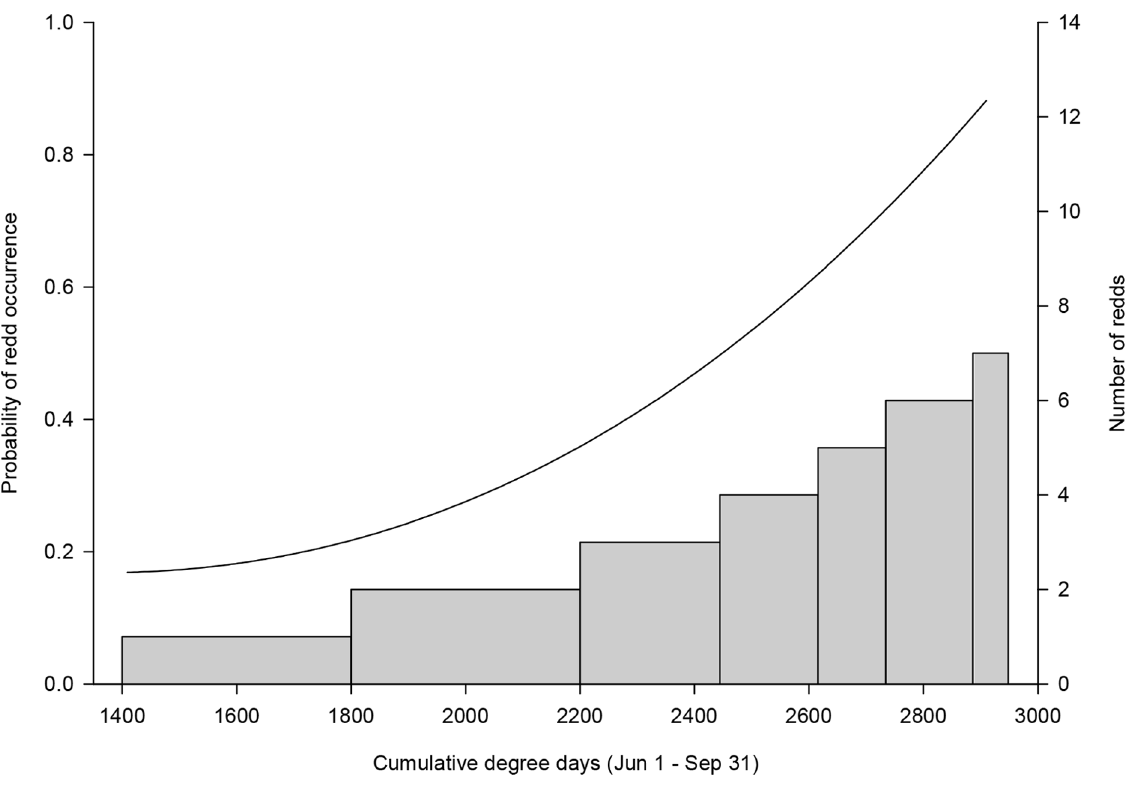
Figure 3. Probability of occurrence (line, left y-axis) and abundance of steelhead redds (bars, right y-axis) as a function of cumulative degree days (GSDD; 6 C) estimated from a hurdle count regression model. Horizontal thickness of bars indicates the approximate range of degree days predicted for a given count estimate.